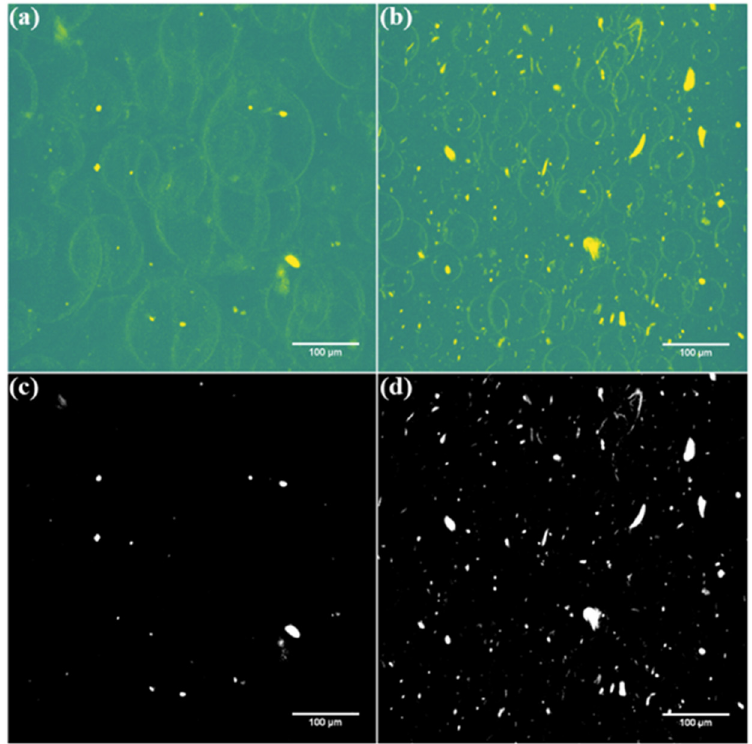
Figure 14. Micro-CT tomograms in high-contrast color revealing CNT network and pores and greyscale depicting only the CNT network: ( a , c ) untreated CNT nanocomposite; ( b , d ) Eu:Y 2 O 3 -CNT nanocomposite.